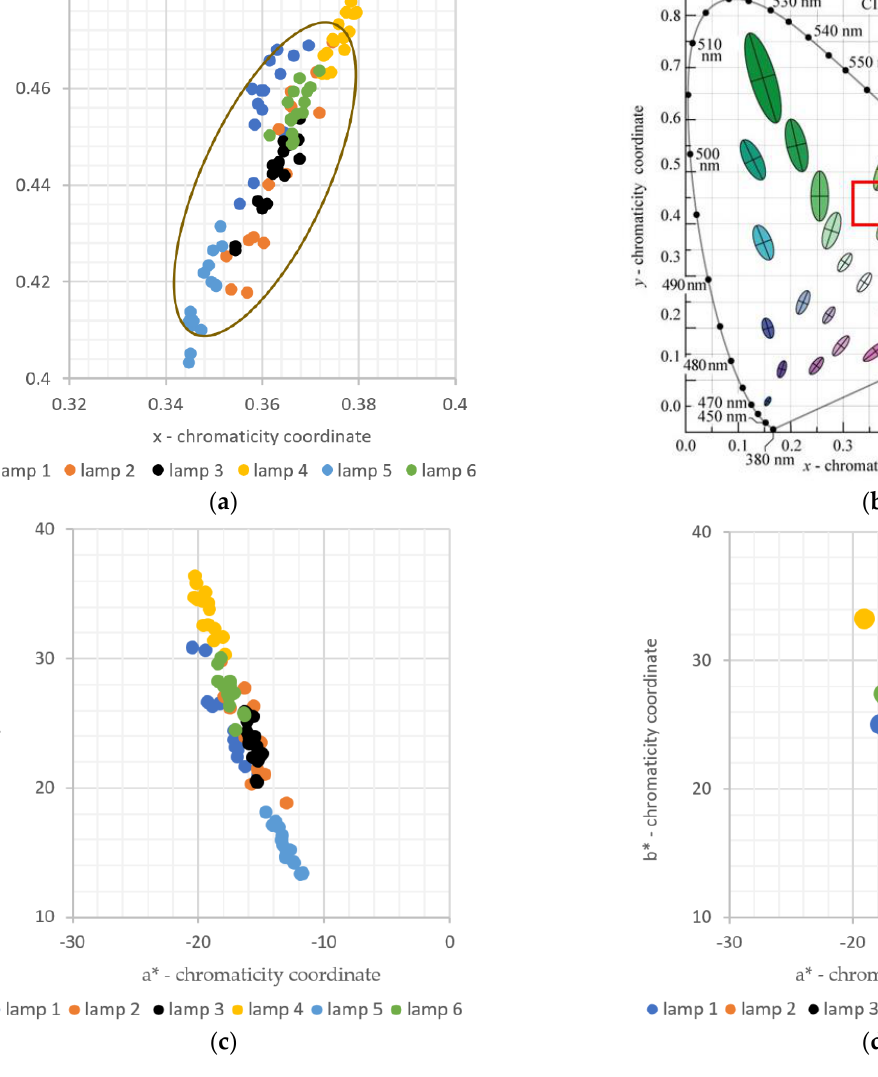
Figure 4. ( a ) CIE 1931 colorimetric coordinates of all measured points of mint leaves, with a MacAdam ellipse, magnified 10× for better readability. ( b ) CIE 1931 colorimetric diagram with marked MacAdam ellipses [39] and the red square marking the area presented in ( a ). ( c ) CIE 2000 L*a*b* colorimetric coordinates of all measured points of mint leaves. ( d ) Averaged CIE 2000 L*a*b* colorimetric coordinates of all measured groups of leaves; MacAdam ellipses in ( b ) are also magnified 10× for better readability.